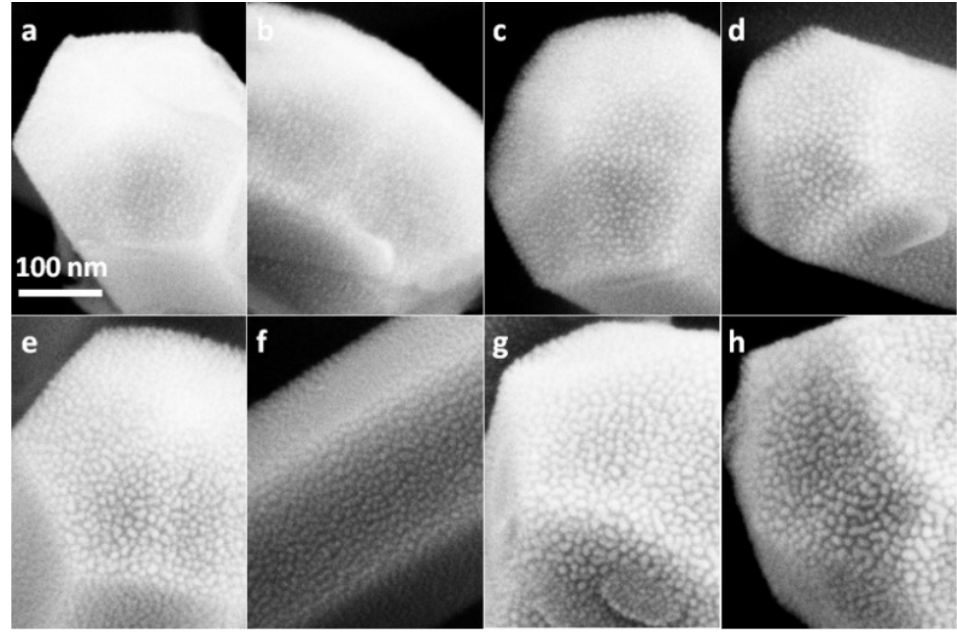
Figure 4. SEM images of Au@ZnO-NRs substrates with sputtering time of 20 s ( a ), 40 s ( b ), 60 s ( c ), 80 s ( d ), 100 s ( e ), 120 s ( f ), 140 s ( g ), and 160 s ( h ).